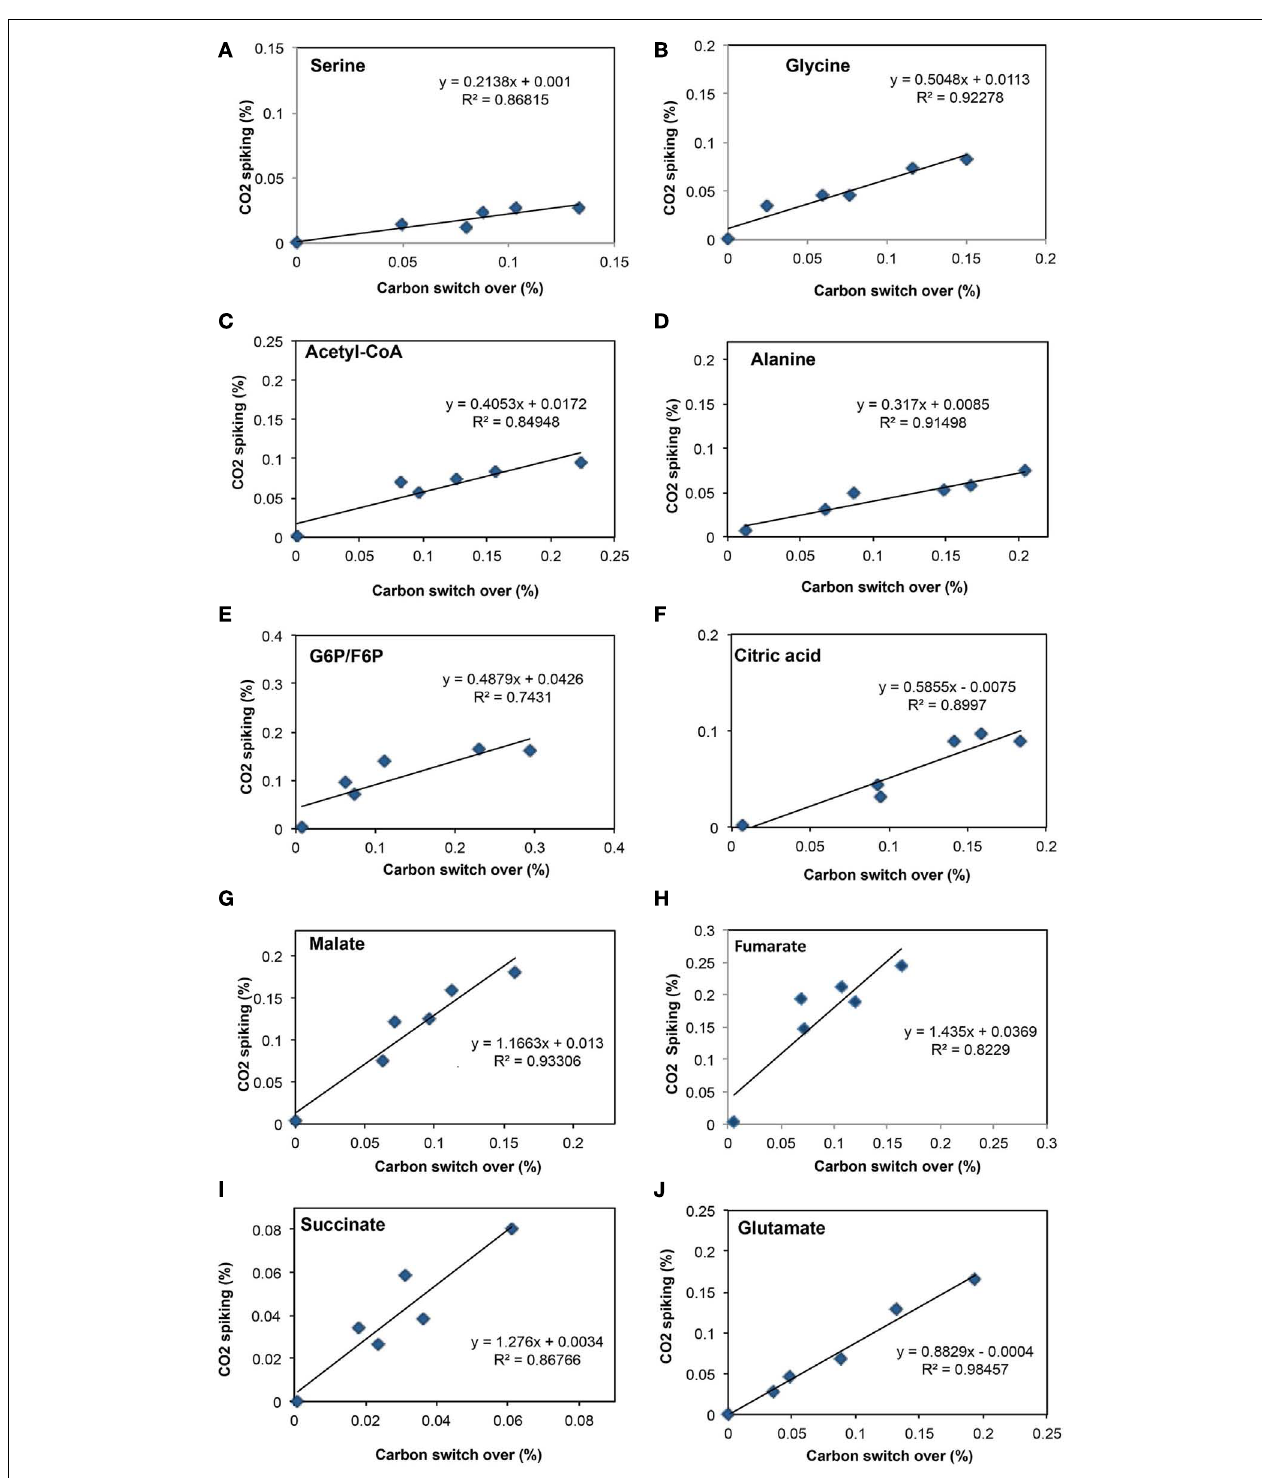
10, and 20min were best fit and the slope of the resulting line used to estimate the relative rate of incorporation into serine (A) , glycine (B) , acetyl-CoA (C) , alanine (D) , glucose-6-phosphate/fructose-6-phosphate (E) , citric acid (F) , malate (G) , fumarate (H) , succinate (I) , and glutamate (J)